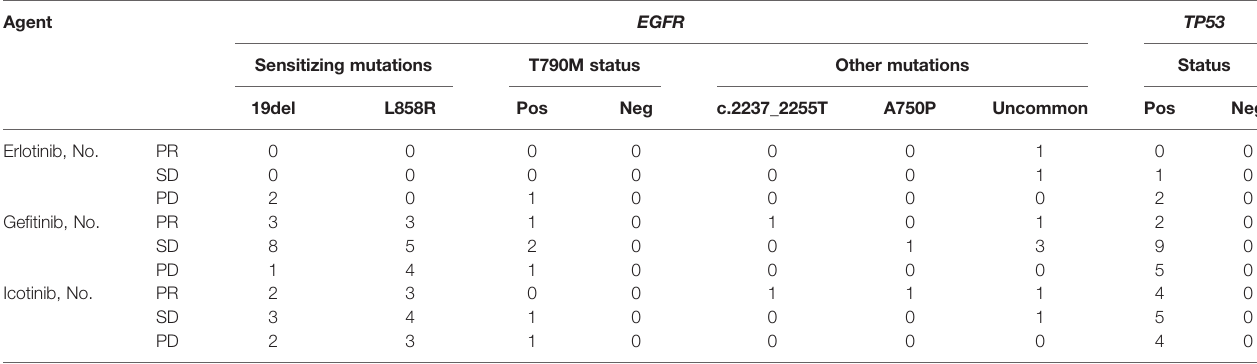
TABLE 5 | The tumor response to targeted agents was associated with genomic subtyping in NSCLC. Agent EGFR TP53 Sensitizing mutations T790M status Other mutations 19del L858R Pos Neg Uncommon Pos Neg Erlotinib,